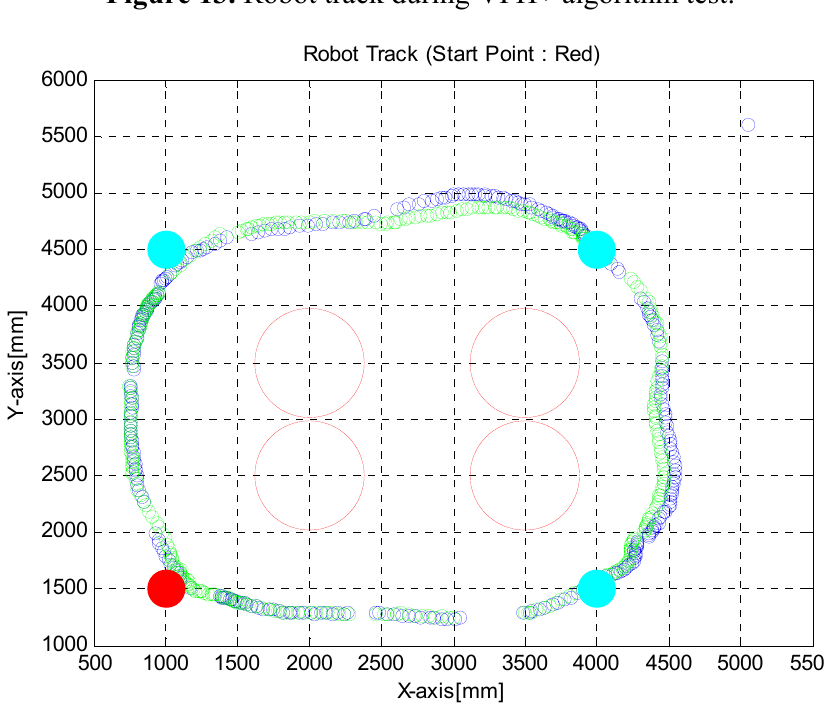
Figure 13. Robot track during VFH+ algorithm